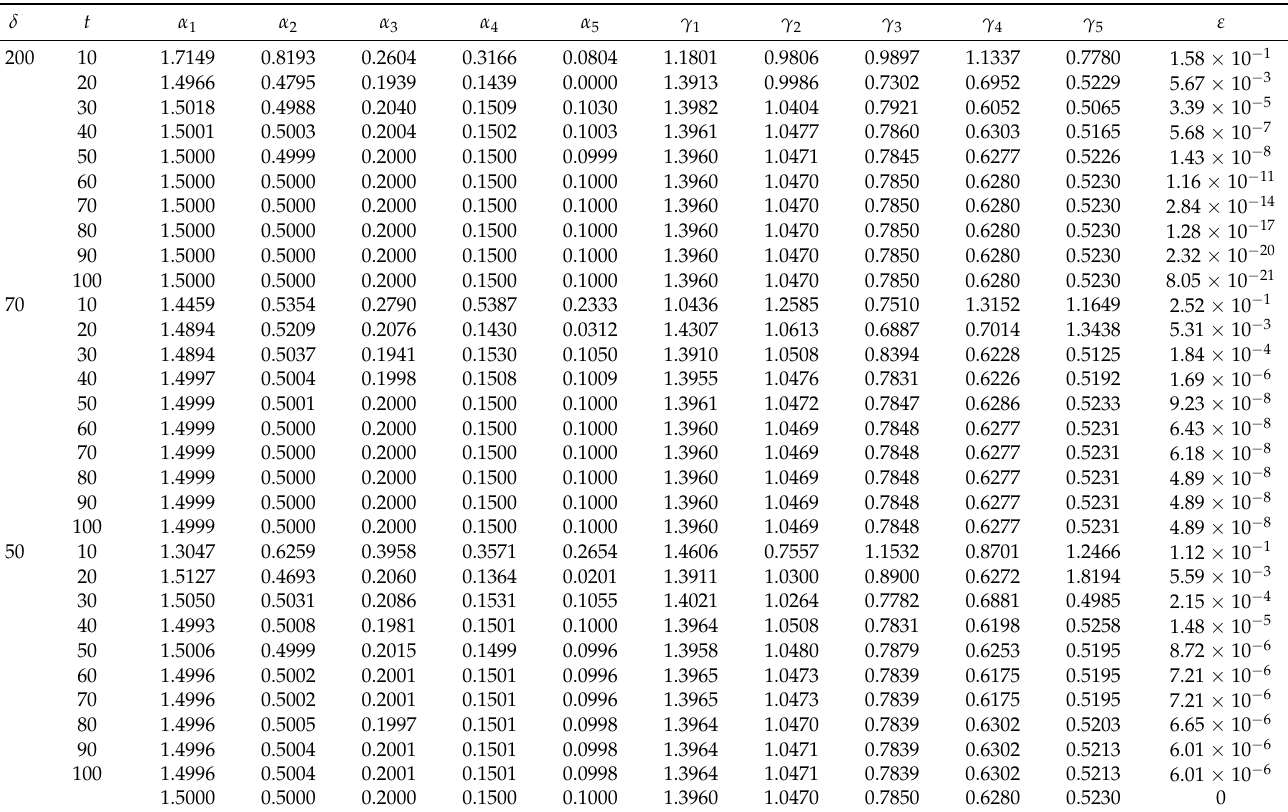
Table 2. Fitness results along with the estimated values for λ = 0.5.